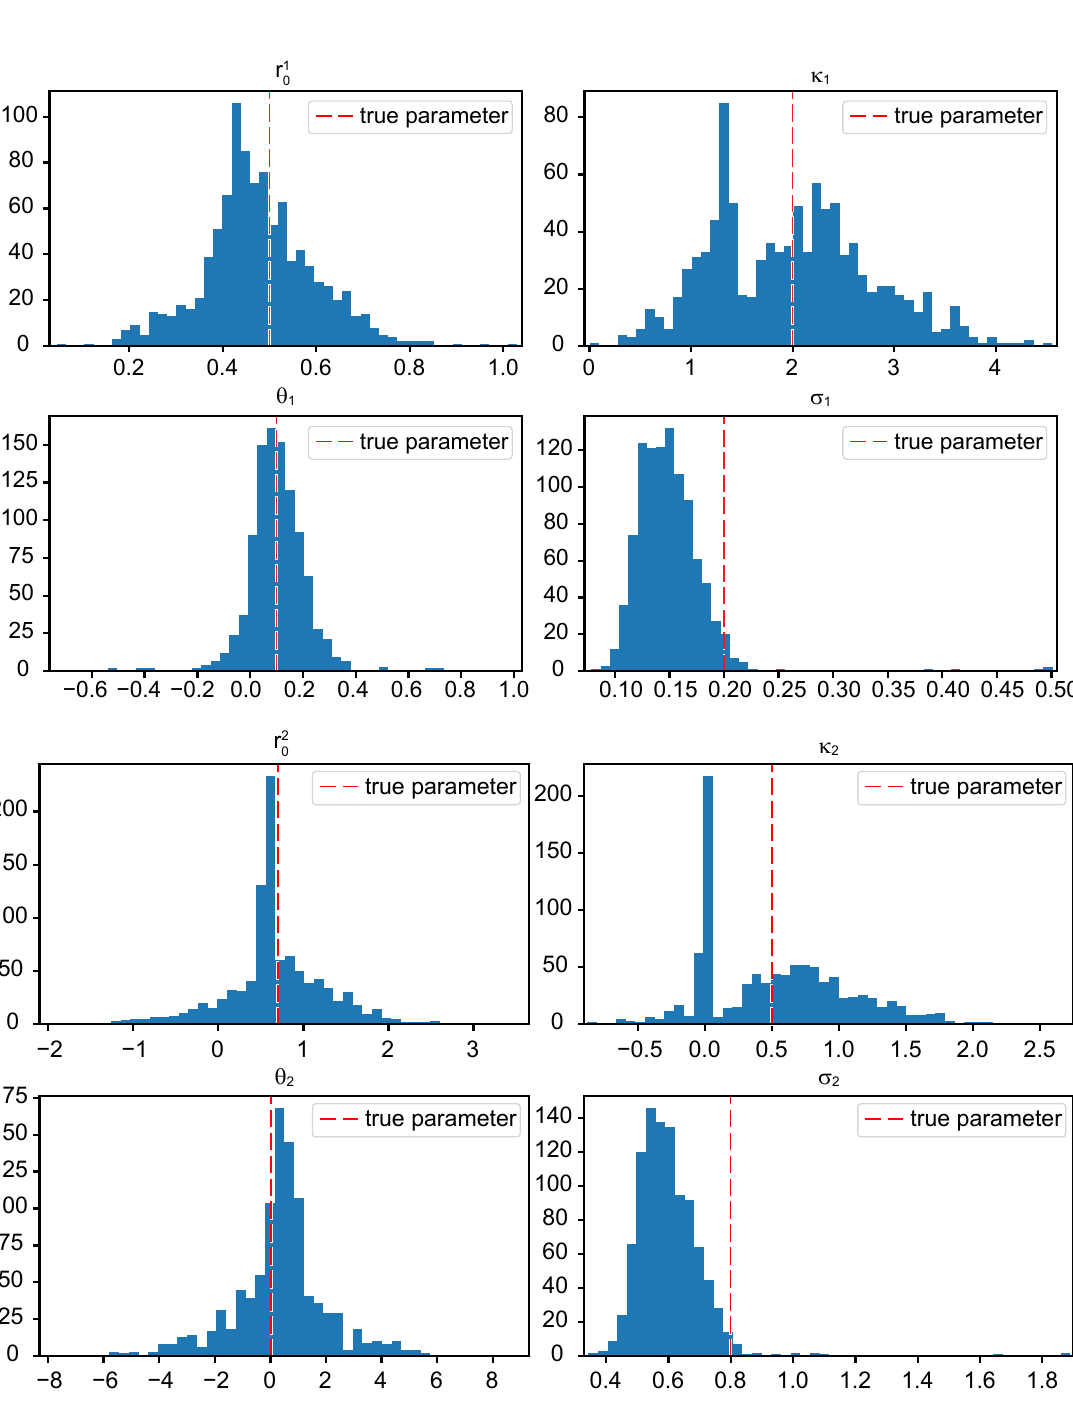
Figure 5. Histogram of the learned parameters with the conjugate gradient (CG) optimizer. Total simulations: 1000. We note that the learned parameters are centered around the true parameter values except for the volatility parameters σ 1 and σ 2 , exhibiting a shift. In statistics, the task of estimating the volatility parameters is well known. However, our observations reveal that the task of finding the volatility parameter in the multi-curve Vasiˇcek interest rate model constitutes a challenging task. Moreover, the range of the parameters, especially for θ 2 , is very